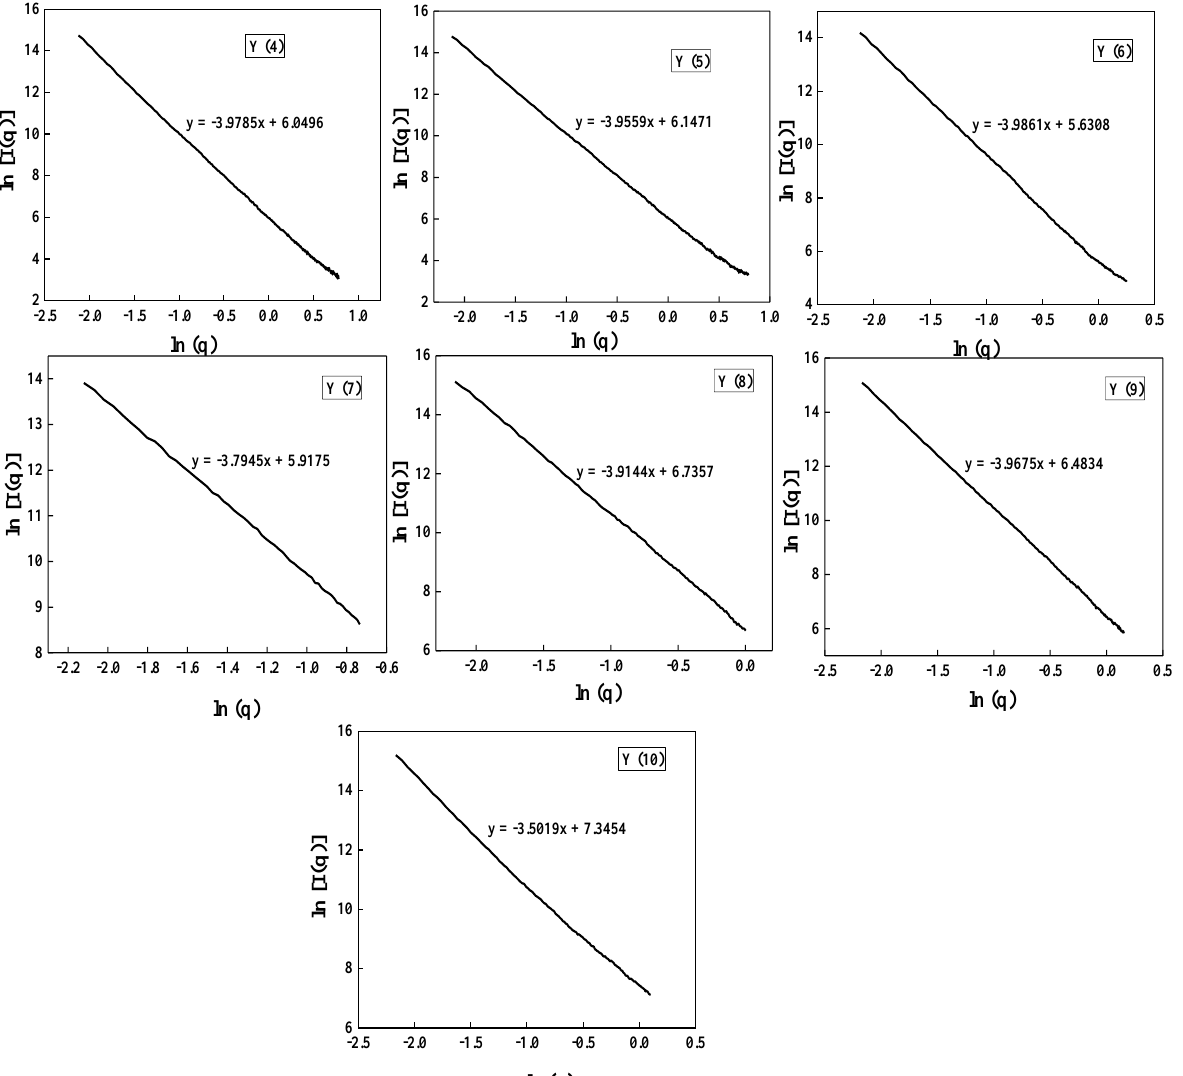
Figure 4. Graphical representation of scattering data from which the scattering exponent ( α = slope) was estimated in the case of zeolite Y using linear regression. The best-fit equation is depicted for each data set.